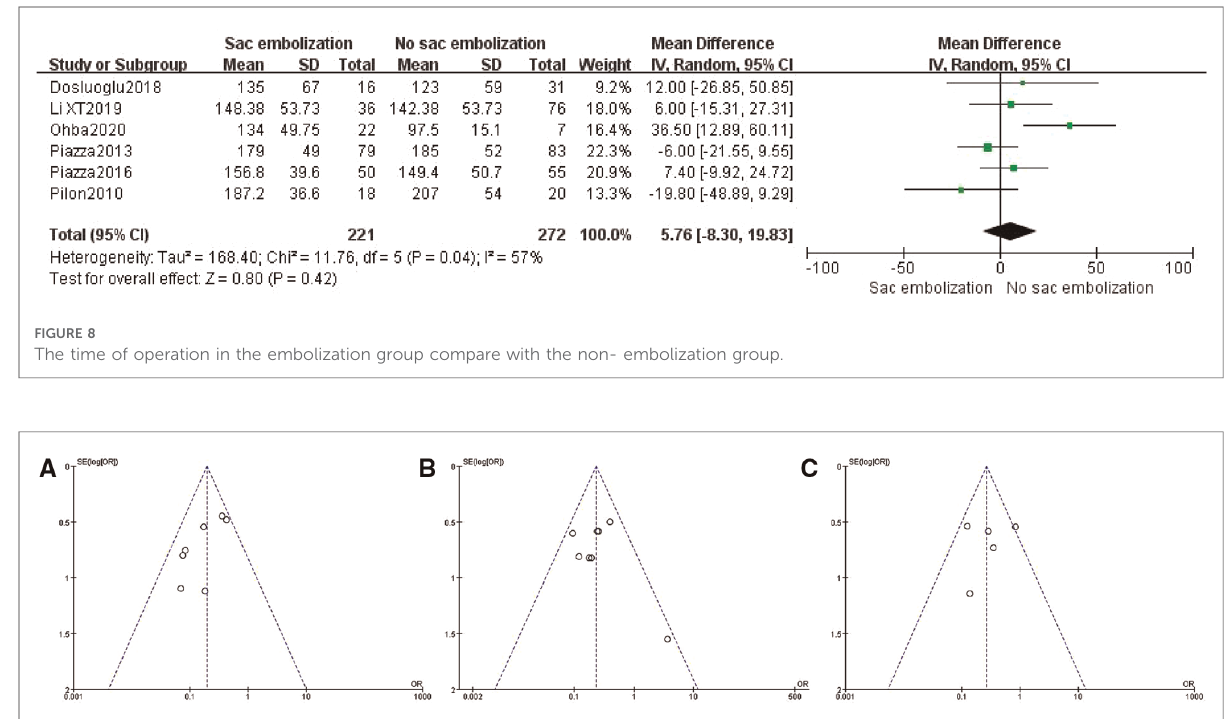
FIGURE 9 Publication bias (according to incidence of early-term ( A ), mid-term ( B ), and late-term ( C ) type II